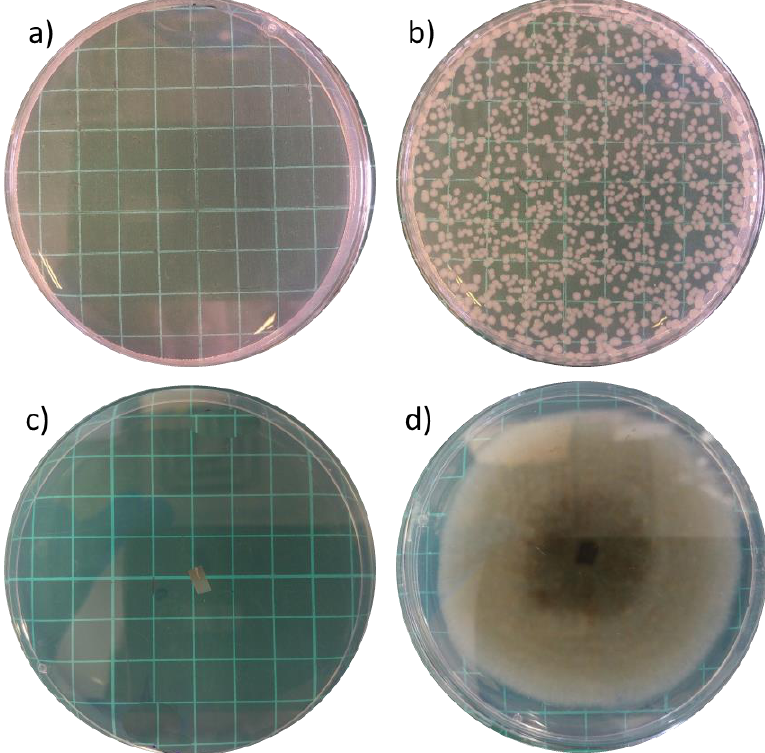
Figure 3. Antimicrobial and antifungal effects of the carvacrol-containing multilayered films exhibited in the micro-atmosphere diffusion in vitro assays, i.e., without direct contact between the studied films and the microbial cultures. ( a ) full inhibition of E. coli growth after incubation with a 9-layer (LDPE/[HNTs/carvacrol])/EVOH film; ( b ) unhindered E. coli growth after incubation with a 9-layer LDPE/EVOH film; ( c ) full inhibition of A. alternata development after incubation with a 9-layer (LDPE/[HNTs/carvacrol])/EVOH film; and ( d ) unhindered A. alternata development after incubation with a 9-layer LDPE/EVOH film. The E. coli were incubated with the films for 16 h at 37 °C and the A. alternata for 5 days at 25 °C in the dark. The results presented in ( a ) and ( c ) are characteristic for all carvacrol-containing films. The results presented in ( b ) and ( d ) are characteristic for all carvacrol-free films. All photographs were taken after the films were removed. Table 5. Growth reduction of A. alternata and Rhizopus spp . exposed to multilayered films. Studies were performed in vitro and using cherry tomatoes as a food